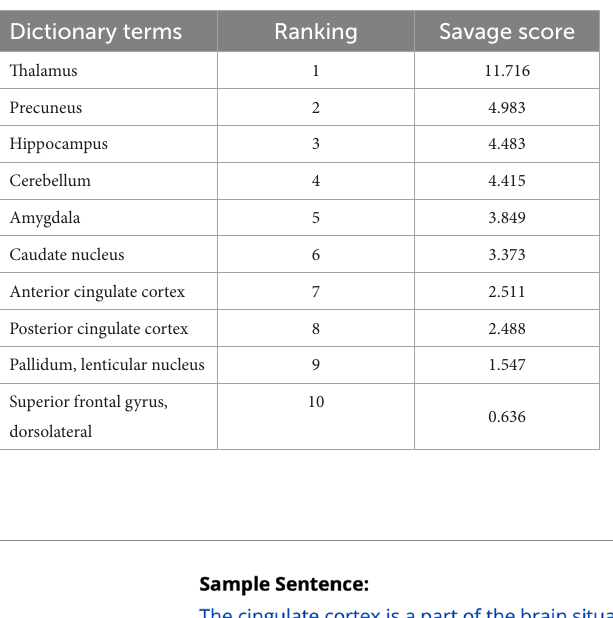
TABLE 3 The top 10 highest ranked dictionary terms by Savage